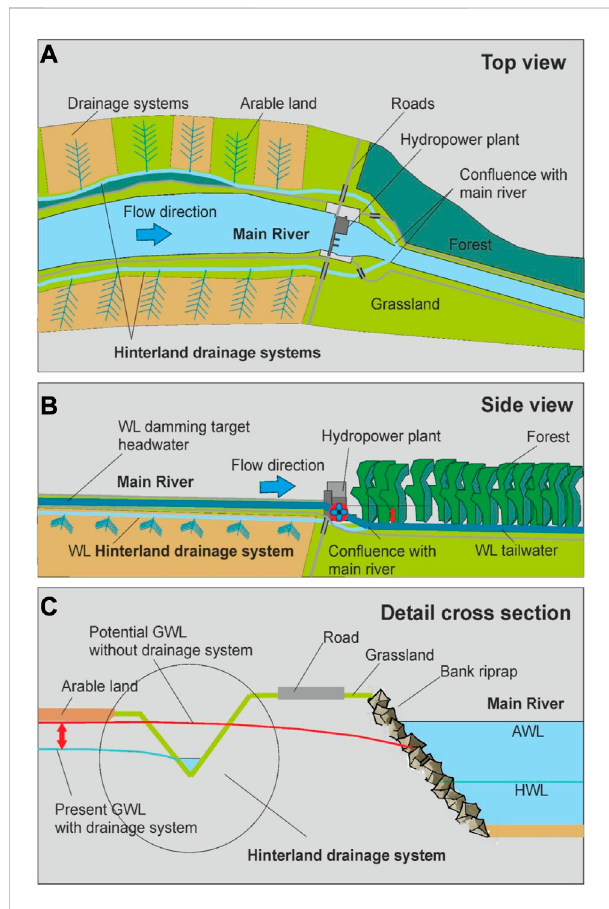
FIGURE 1 Construction scheme of a typical Heavily Modi fi ed Water Body (HMWB) with hinterland drainage systems (HDS). (A) top view, (B) side view and (C) detail of the cross section, WL, water level; GWL, ground water level; AWL, actual water level of the main river after the dam construction; HWL, historic water level of the natural main